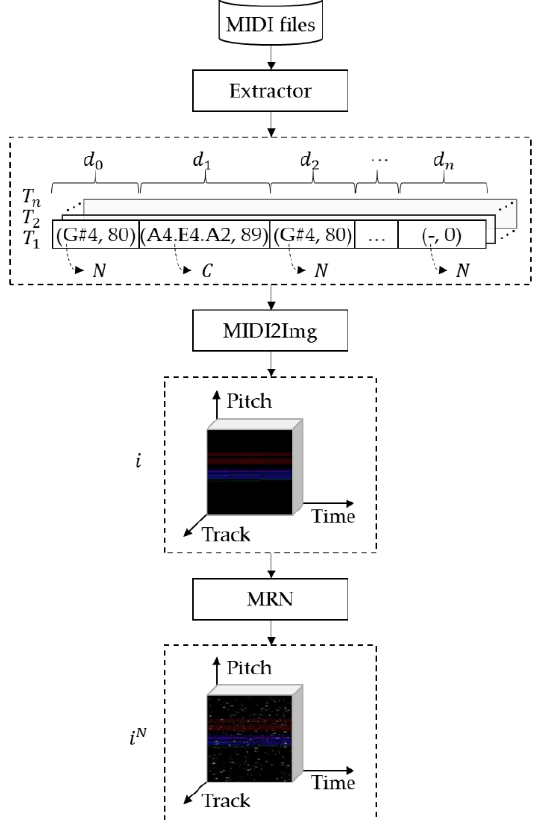
Figure 1. Preprocessing of MIDI preprocessing.